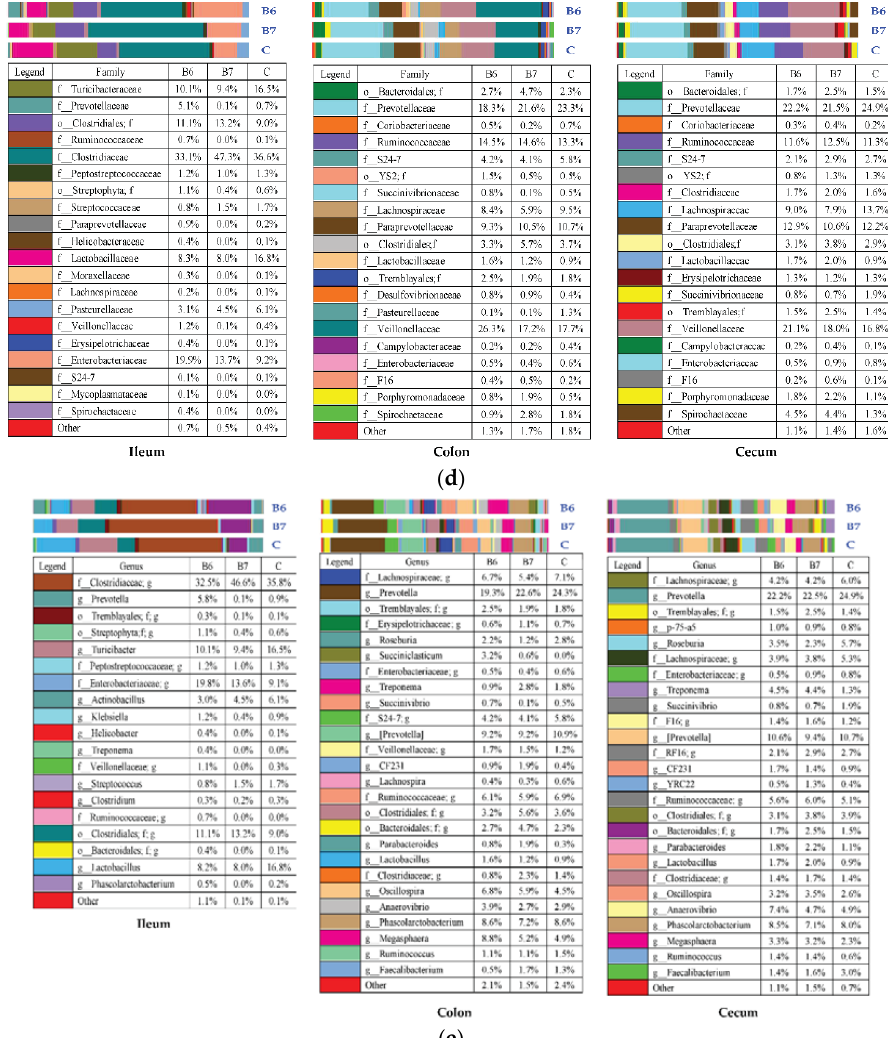
Figure 4. ( a ) The community composition at the phylum level; ( b ) the community composition at the class level; ( c ) the community composition at the order level; ( d ) the community composition at the family level; and ( e ) the community composition at the genus level.